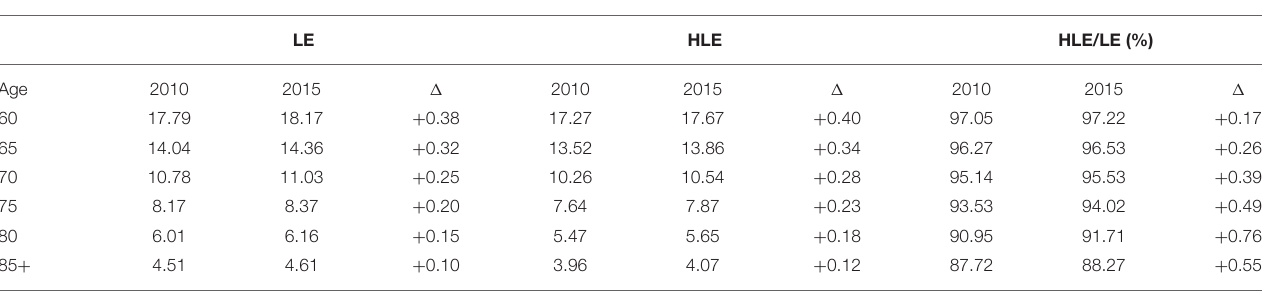
TABLE 3 | Disability–free life expectancy of the elderly in 2010 and 2015. Male LE HLE HLE/LE